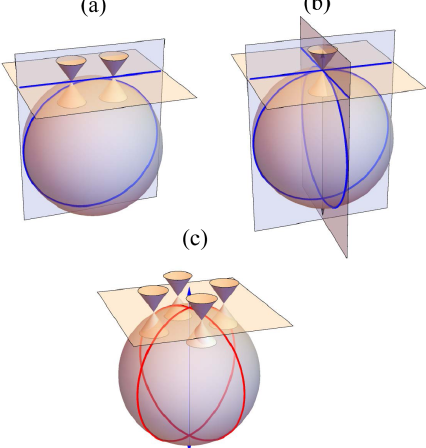
FIG. 7. Illustration of the surface dispersion in planes tangent to the sphere whose normal is (a) in a single mirror plane, (b) in two mirror planes, or (c) parallel to a fourfold rotation